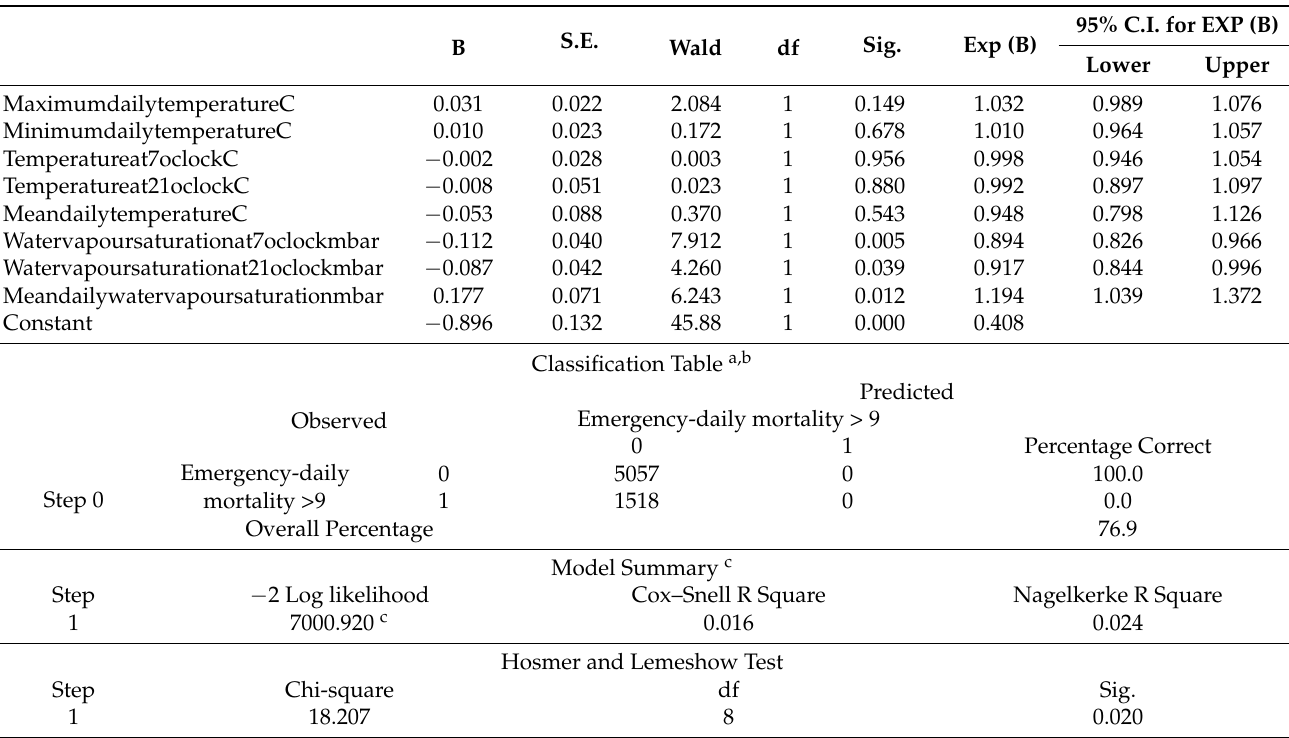
Table 9. Results of applied binary regression with selected subset of 8